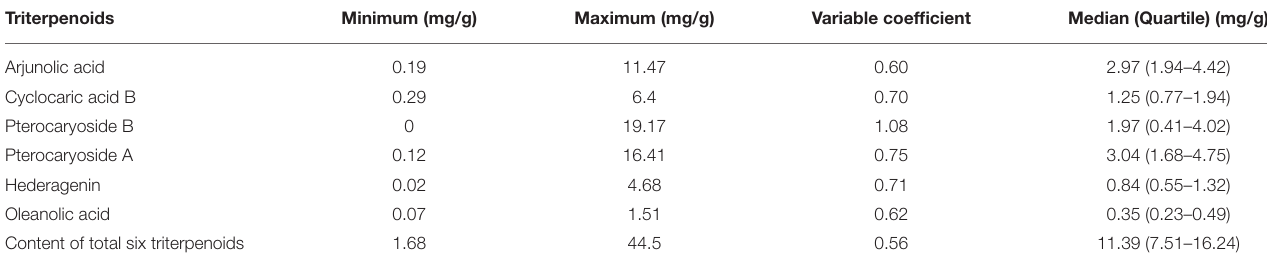
TABLE 2 | Triterpenoid concentrations in leaves of 316 C. paliurus individuals.